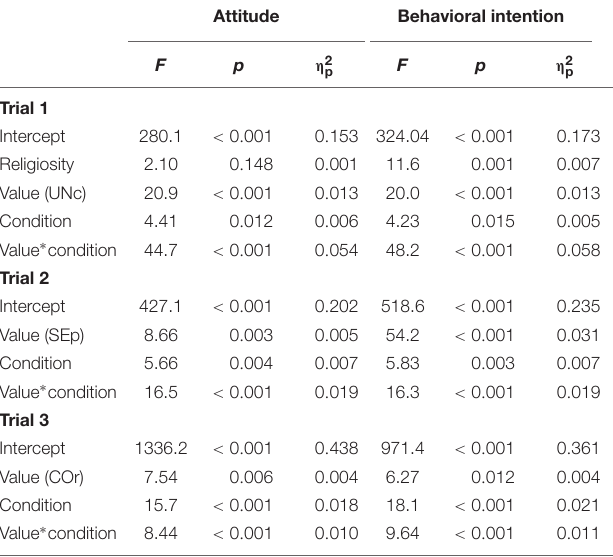
TABLE 2 | Summary of analyses of covariance. TABLE 3 | Simple slope analyses for the effects of value on attitude and behavioral intention in each experimental